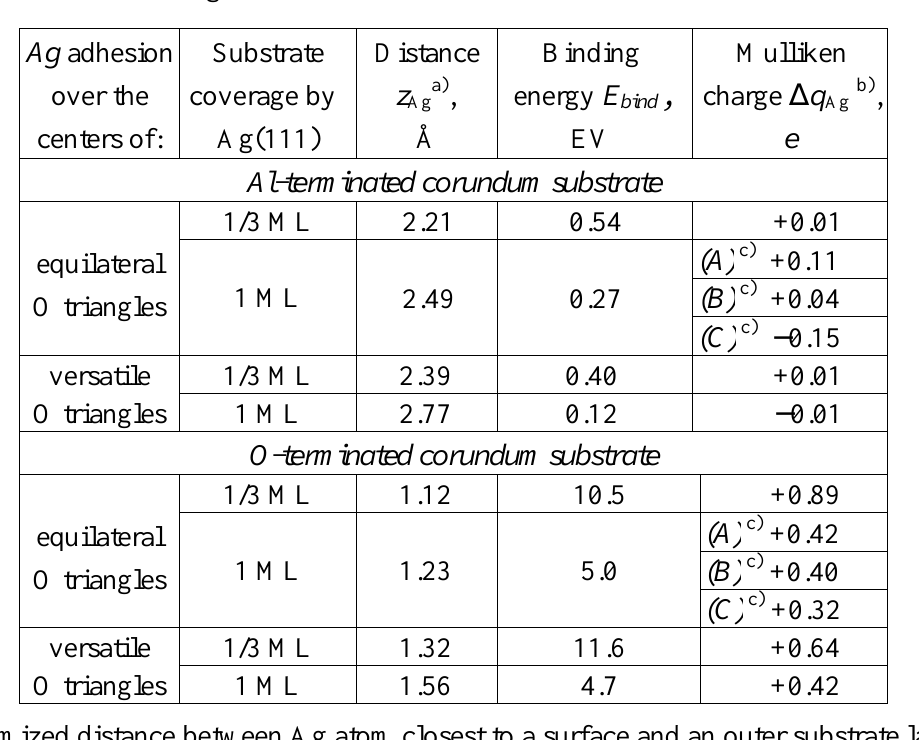
O (0001) interface. Silver 2 3